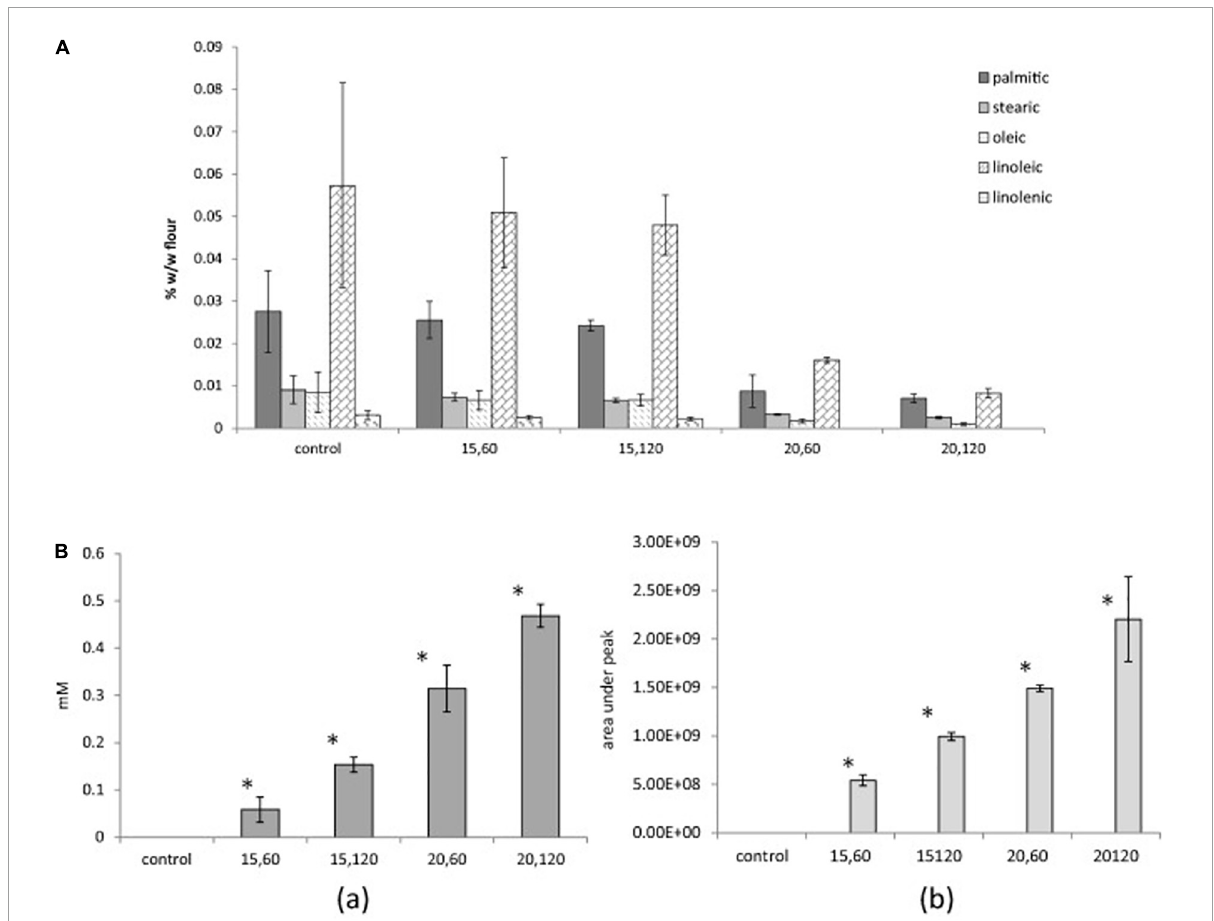
FIGURE3 (A) Free fatty acids (FFAs) composition of control and cold plasma (CP)-treated wheat flour samples: 15, 60 (15 V, 60 s); 15, 120 (15 V, 120 s); 20, 60 (20 V, 60 s); and 20, 120 (20 V, 120 s). (B) Lipid oxidation markers (a) PV (hydroperoxide value) and (b) n-hexanal of control and CP-treated wheat flour samples: 15, 60 (15 V, 60 s); 15, 120 (15 V, 120 s); 20, 60 (20 V, 60 s); and 20, 120 (20 V, 120 s), ∗ difference from control ( p < 0.05)